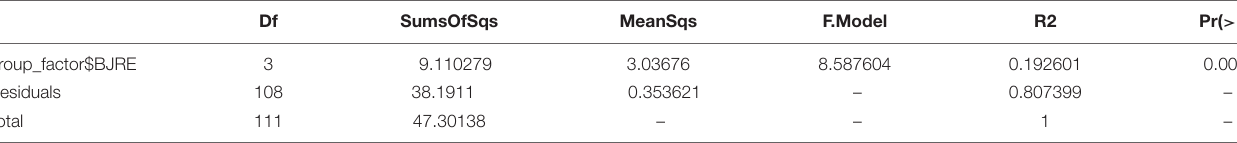
TABLE 2 | Adonis analysis of the difference among bacteria in samples associated with Gossypium sp. Df